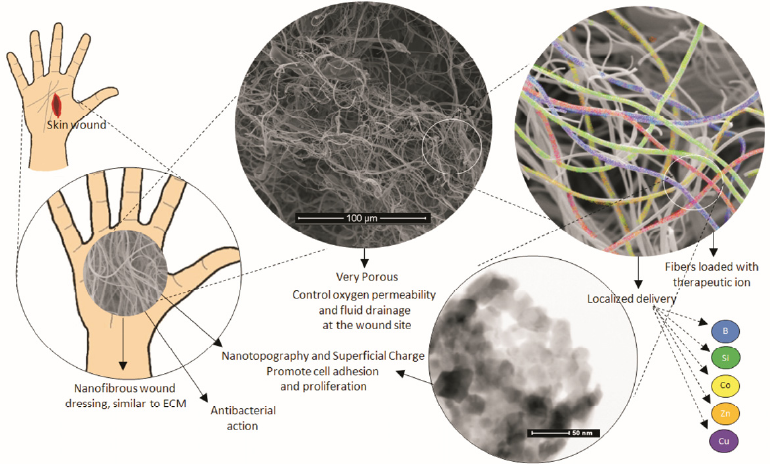
Figure 4. Schematic representation of the influence of ceramic nanofibers on the wound healing process.